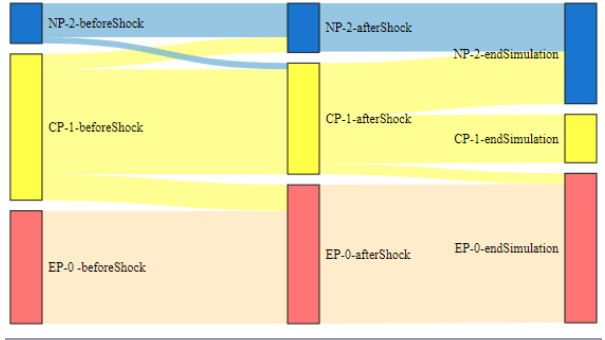
Fig. 4 . Households’ livelihood state at the sampled time slots (shock scenarios). The bottom is the extremely poor (EP-0) state, the middle panel is the chronic poor (CP-1), and the top section is the nonpoor (NP-2). Description is the same as Figure 3, however, the proportion of flows is different from Figure